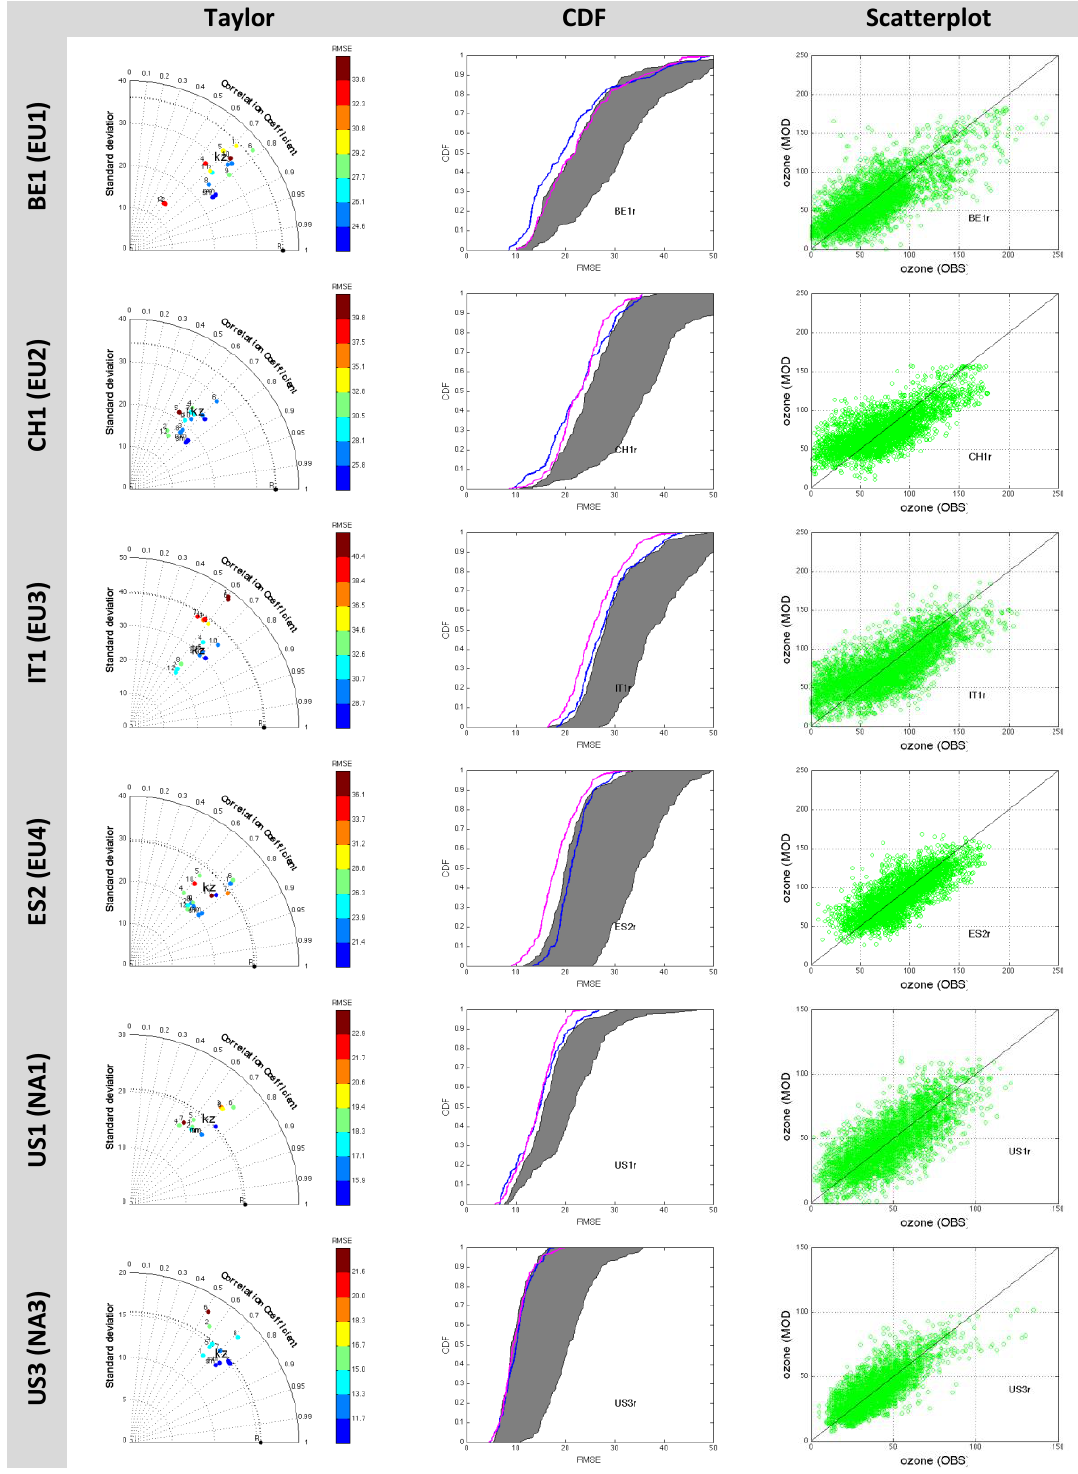
Fig. 14a. Indicative results at the station level. (a) (left column) Taylor diagrams for the examined stations corresponding to the prediction week; (middle column) the cumulative density function of the RMSE distribution of the best and worst deterministic model (shaded area) together with the distribution of kz model (magenta) and mm (blue); (right column) scatterplot of all examined cases corresponding to the prediction